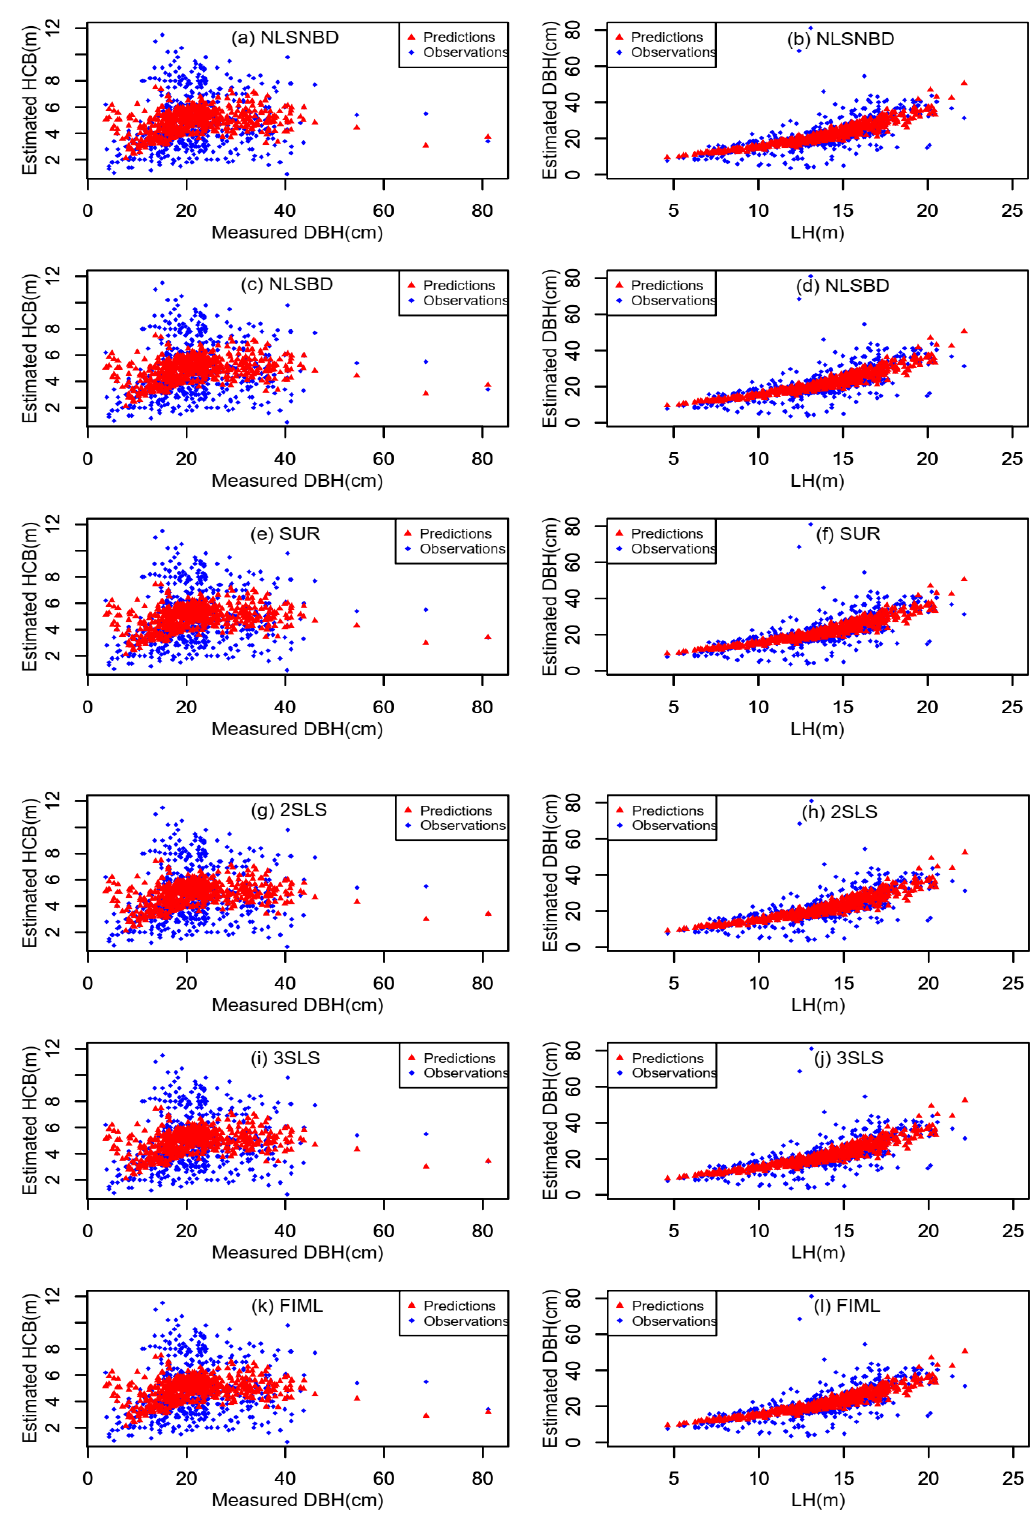
Figure 7. Scattered plots of estimated values of HCB versus ground-measured DBH for nonlinear least squares with HCB estimation not based on DBH (NLS and NBD) ( a ), nonlinear least squares with HCB estimation based on the DBH (NLS and BD) ( c ), NSUR ( e ), 2SLS regression ( g ), 3SLS regression ( i ), and FIML ( k ). Scattered plots of estimated DBH versus LH for NLS and NBD ( b ), NLS and BD ( d ), NSUR ( f ), 2SLS ( h ), 3SLS ( j ), and FIML ( l ).